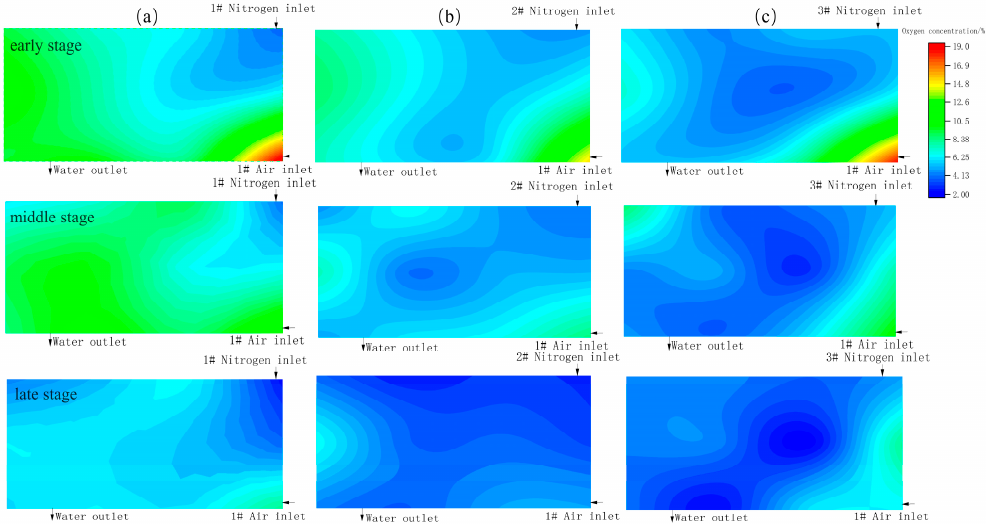
Figure 7. Change characteristics of SC hazardous area in the goaf under different nitrogen injection positions. ( a ) 1# nitrogen injection, ( b ) 2# nitrogen injection, ( c ) 3# nitrogen injection.